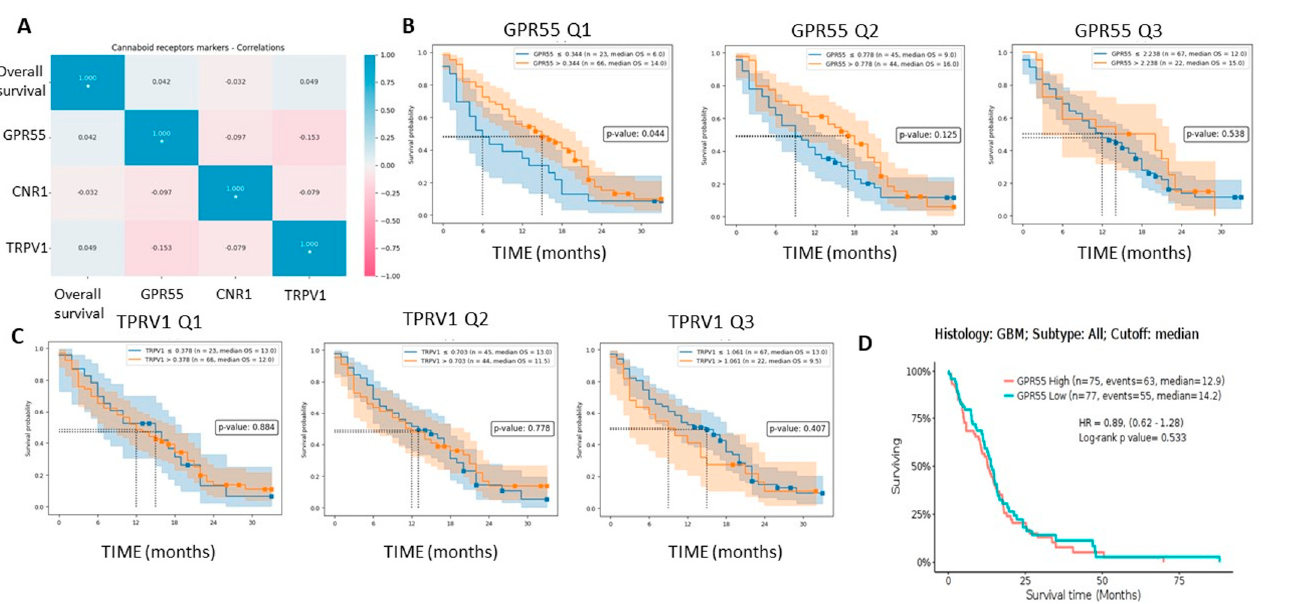
Figure 3. Correlation matrix and overall survival curves for cannabinoid receptor expressions in GBMs. ( A ) Correlation matrix data show positive significance between GBM patient ( n = 89) survival and GPR55 ( p = 0.042) and TRPV1 ( p = 0.049) receptor gene expressions. ( B , C ) Kaplan–Meier survival curves of GBM patients ( n = 89) stratified by three cut-off levels of GPR55 ( B ) and TRPV1 ( C ) mRNA expression. ( D ) Kaplan–Meier survival curves of GBM patients, as analysed from the TCGA data bank GLIOVIS with GBM patients ( n = 152) with GPR55 mRNA expression level data. Survival at median value was not significant. GBM: glioblastoma. * p < 0.05.